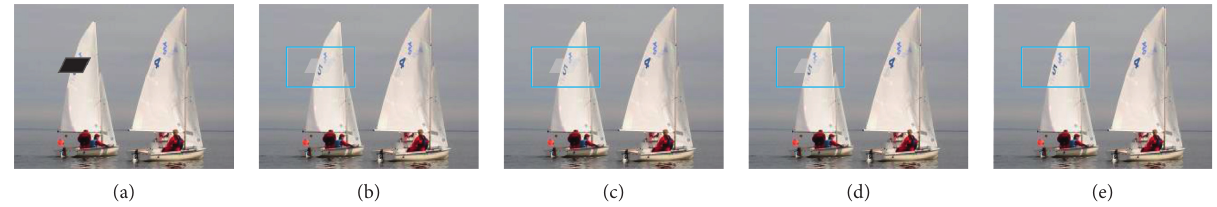
Figure 8: Object removal color image restoration effect comparison chart. (a) Original image, (b) Criminisi algorithm result, (c) adaptive repair algorithm result, (d) sparsity repair algorithm result, and (e) algorithm result of this paper.